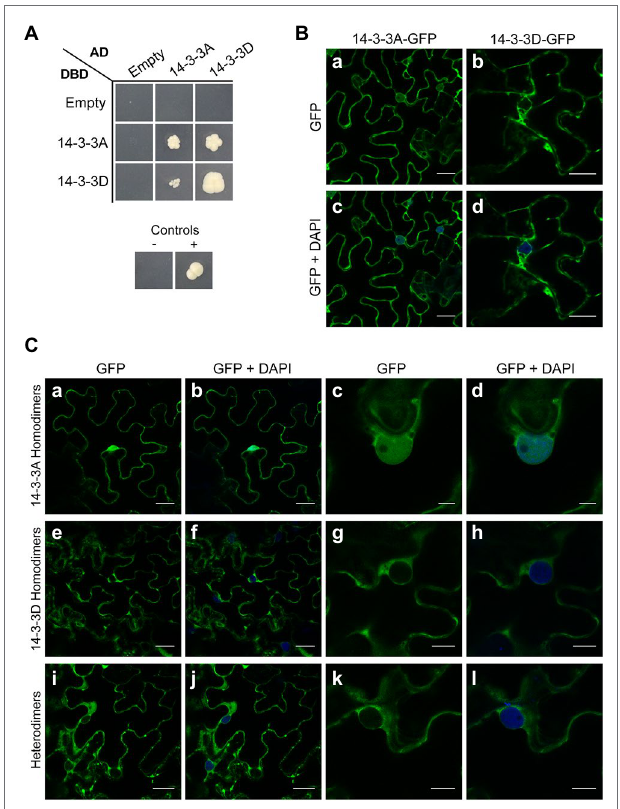
FIGURE 2 | Dimerization and subcellular localization of 14-3-3A and 14-3-3D. (A) Y2H assay testing the dimerization of 14-3-3A and 14-3-3D proteins. Selective medium: SC-Leu-Trp-His +1 mM 3AT. C−: Negative interaction control; C+: positive interaction control. AD—Activation domain; DBD—DNA binding domain. (B) Subcellular localization of 14-3-3A-GFP and 14-3-3D-GFP. (Ba) Cytosolic and nuclear localization of 14-3-3A-GFP, bar 20 μm. (Bc) Merged image of 14-3-3A-GFP localization and nuclear DAPI staining, bar 20 μm. (Bb) Cytosolic localization of 14-3-3D-GFP, bar 15 μm. (Bd) Merged image of 14-3-3D-GFP localization and nuclear DAPI staining, bar 15 μm. (C) Bimolecular Fluorescence Complementation (BiFC) assay showing the dimerization of 14-3-3A and 14-3-3D. (Ca,D) 14-3-3A-nGFP × 14-3-3A-cGFP, showing 14-3-3A homodimers formation in cytosol and nucleus, bars 20 and 5 μm. (Cb,D) Merged images of 14-3-3A homodimers and DAPI staining, bars 20 and 5 μm. (Ce,G) 14-3-3D-nGFP × 14-3-3D-cGFP, showing 14-3-3D homodimers formation in cytosol, bars 20 and 10 μm. (Cf,H) Merged images of 14-3-3D homodimers and DAPI staining, bars 20 and 10 μm. (Ci,K) 14-3-3A-nGFP × 14-3-3D-cGFP, showing heterodimers formation in cytosol, bars 40 and 10 μm. (Cj,L) Merged images of